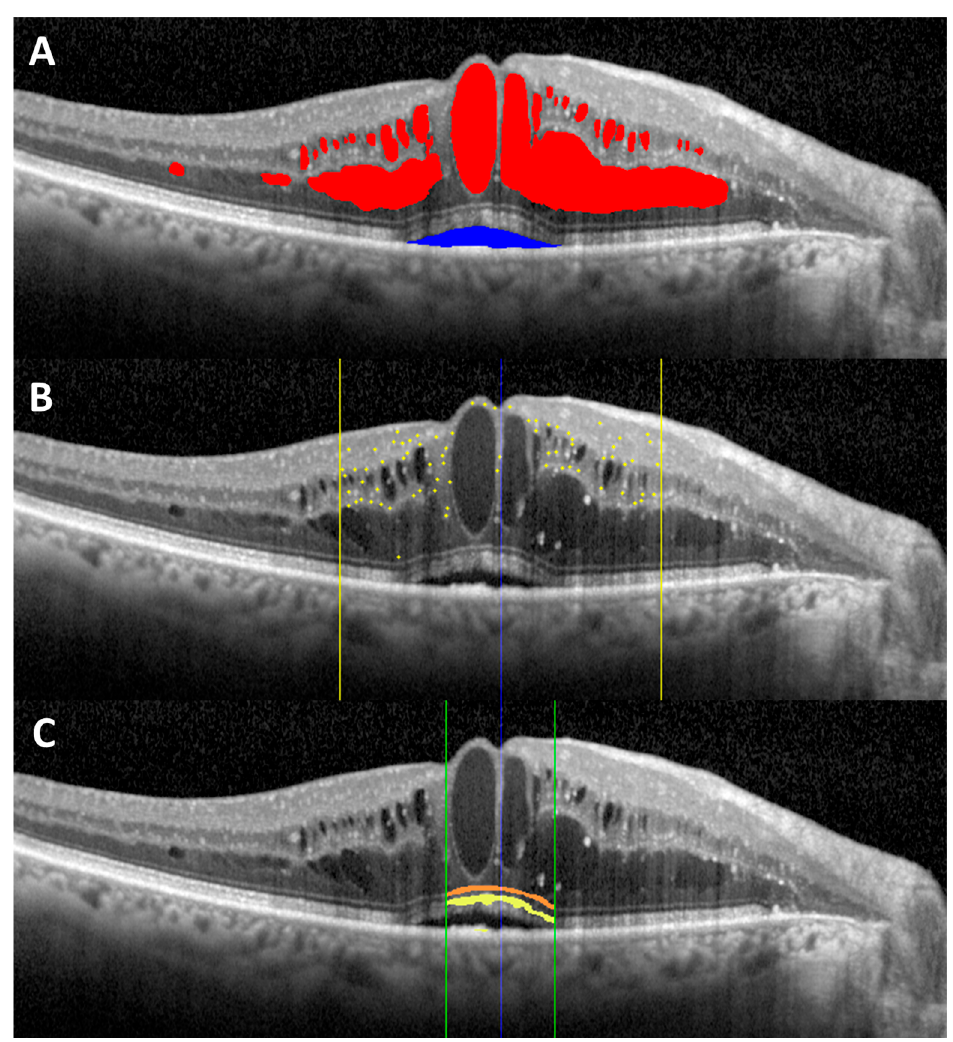
Figure 1. Overview of the different spectral domain optical coherence tomography biomarkers evaluated: ( A ) intraretinal fluid (red) and subretinal fluid (blue); ( B ) hyperreflective retinal foci (yellow dots) localized within the central 3 mm (yellow lines); ( C ) external limiting membrane (orange) and ellipsoid zone (yellow) localized within the central 1 mm (green lines). Table 1. Overview of the hardware/technical requirements for using the AI software.